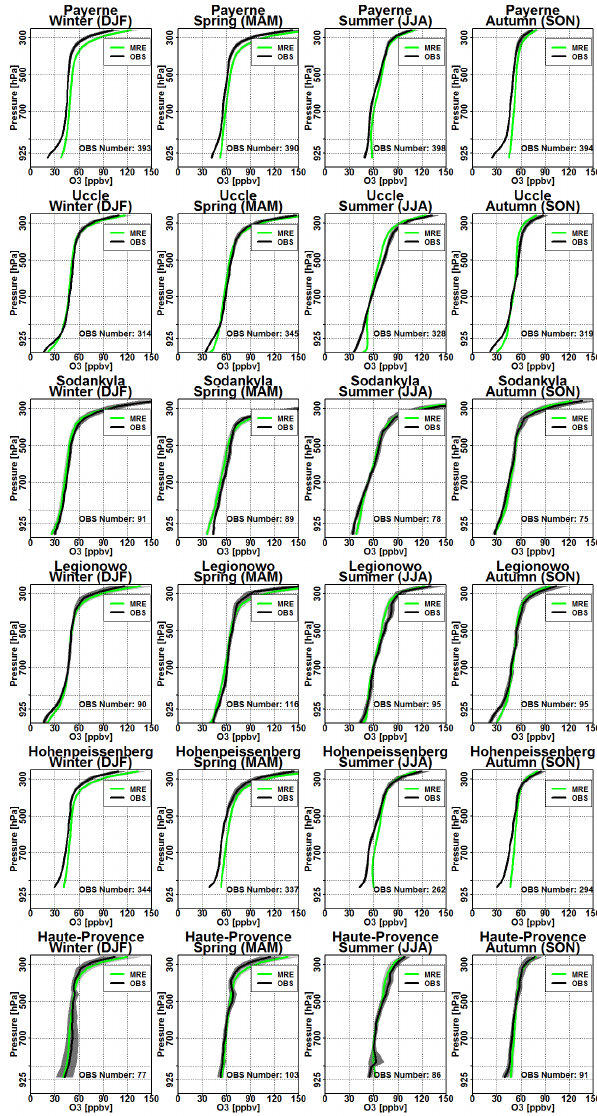
Figure 7. Mean 2003–2012 ozone profiles based on MRE near- surface ozone (green line) and ozonesonde measurements (black line) at the stations of Sodankyla (67.4 ◦ N, 26.6 ◦ E), Legionowo (52.4 ◦ N, 20.9 ◦ E), Uccle (50.8 ◦ N, 4.3 ◦ E), Hohenpeissenberg (47.8 ◦ N, 11 ◦ E), Payerne (46.8 ◦ N, 6.9 ◦ E), and Haute-Provence (43.9 ◦ N, 5.7 ◦ E). The shading areas denote 95% confidence inter- val of the mean